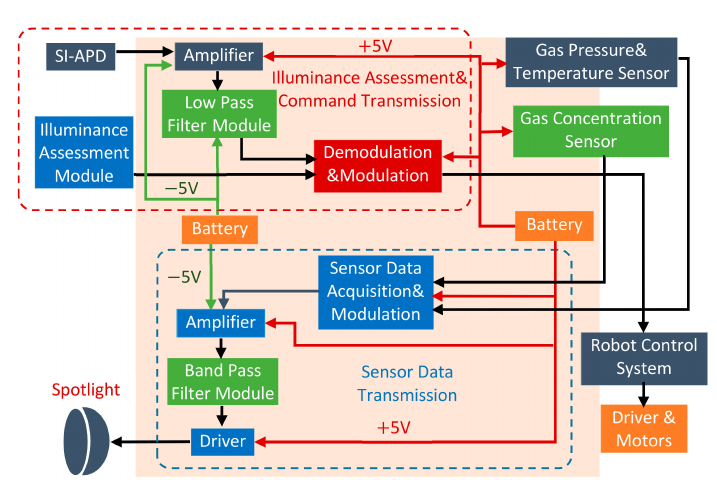
Figure 3. The electrical structure of the follower robot.